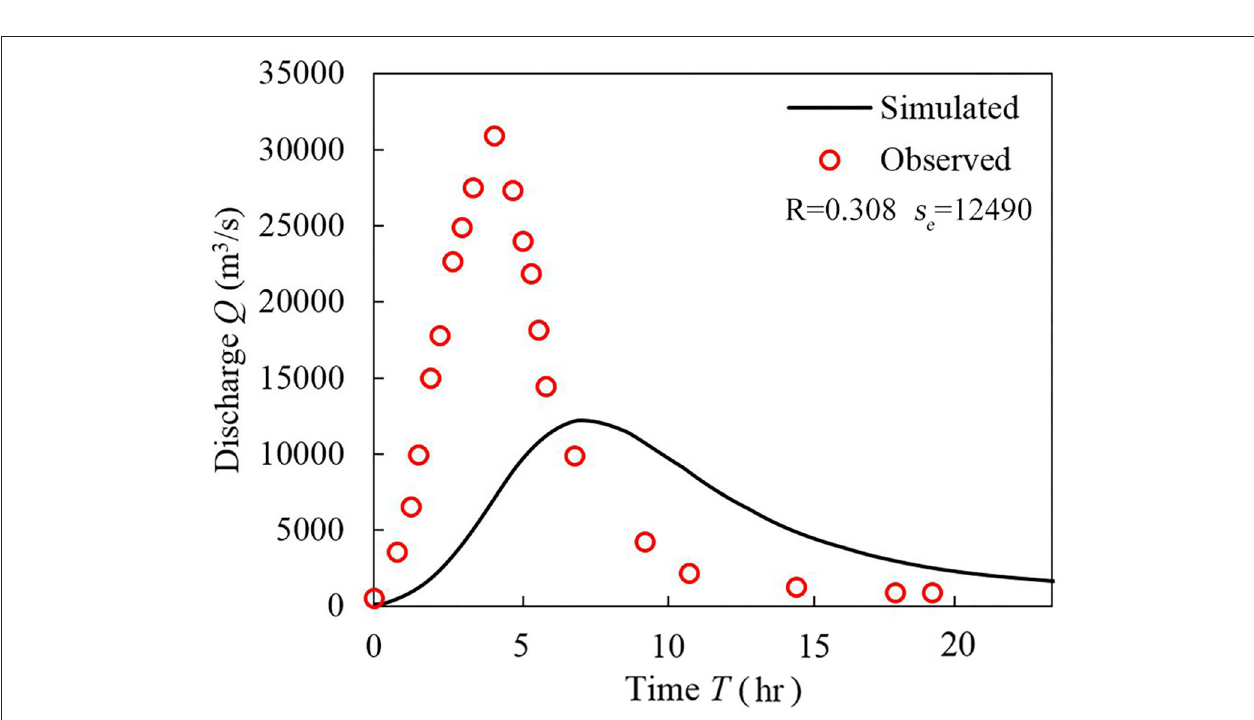
FIGURE 7 | The simulated flow hydrograph of the “November 3” Baige barrier lake compared with the observed data. The Pearson correlation coefficient R is 0.308, and the root mean square error RMSE ( s e ) is 12,490.